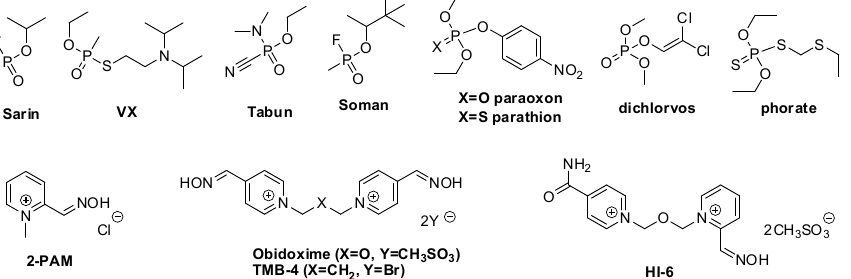
Figure 1. Chemical structures of some organophosphates and currently used pyridinium oxime reactivators. A combination of intramuscular injections of an AChE reactivator of the pyridinium aldoxime family (e.g., pralidoxime ( 2-PAM ), trimedoxime ( TMB-4 ), obidoxime, HI-6